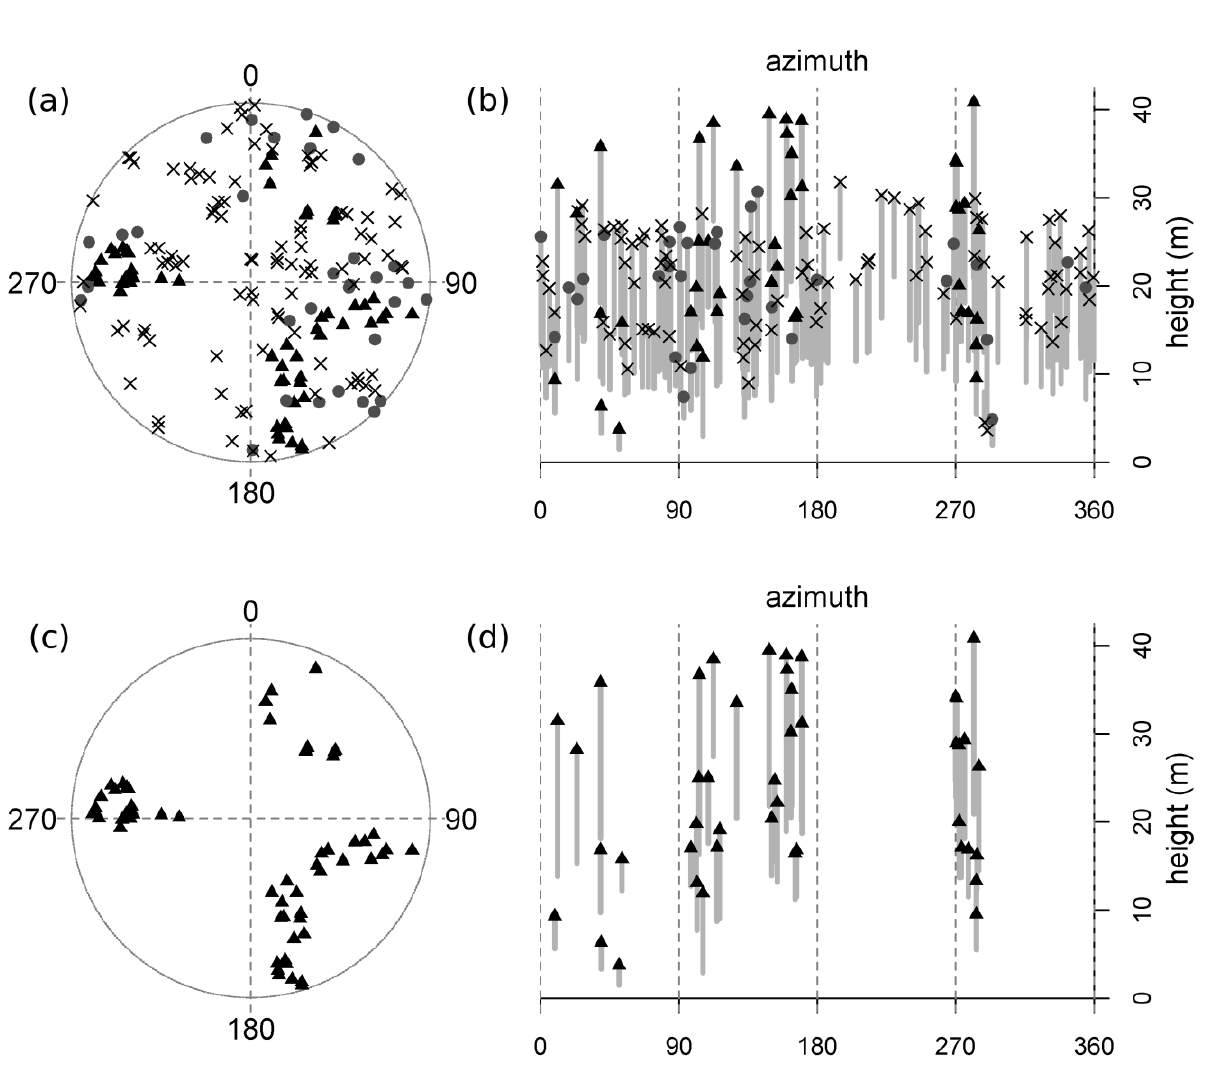
Figure 2. A representative diseased plot (MMWD-S9; see Table 1). Trees are mapped (a & c) and represented vertically (b & d; top height and height-to-live-crown are plotted against azimuth, thus “unrolling” the 360 degree view from plot center, and achieving a two-dimensional image by flattening all distances from plot center into a single plane). The top set of graphs (a & b) displays all trees, including reconstructed dead tanoaks, and the bottom set (c & d) illustrates this plot after the removal of all tanoaks (both living and dead). Symbols represent the following: “X”s = dead tanoak; gray circles = living tanoak; black triangles = redwood; open circles = hardwoods other than tanoak; no conifers other than redwood were present in this plot. Gray bars display the length of the live crown (the symbol at the top of each bar is the total tree height and the lower limit of each bar is the